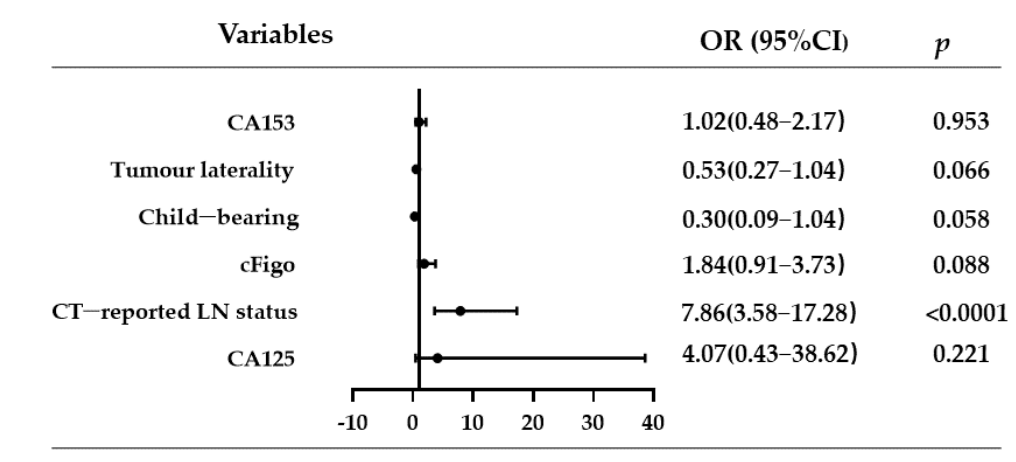
Figure 1. Risk factors in the multivariate regression analysis. Abbreviations: CT, computed tomography; LN, lymph node; cFigo, clinical International Federation of Obstetrics and Gynaecology; OR, odds ratio; CI, confidence interval.